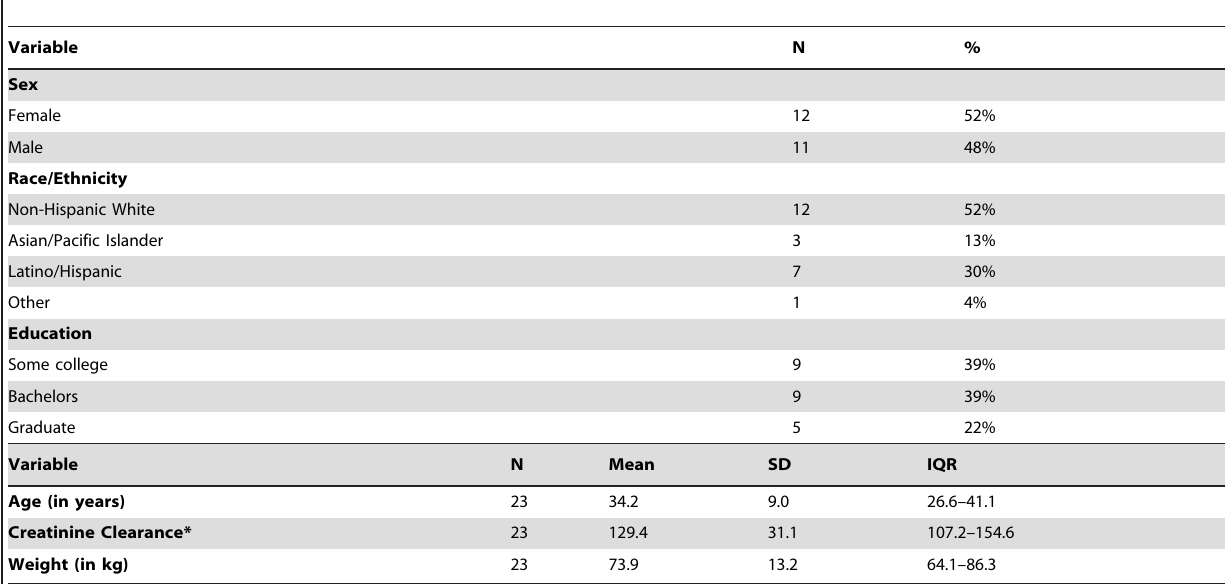
Table 1. Demographics of participants who provided hair samples